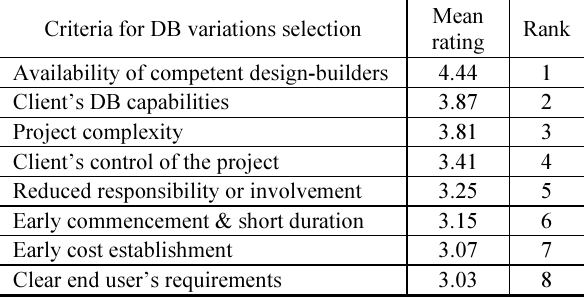
Table 5. The results of round 2 of the Delphi